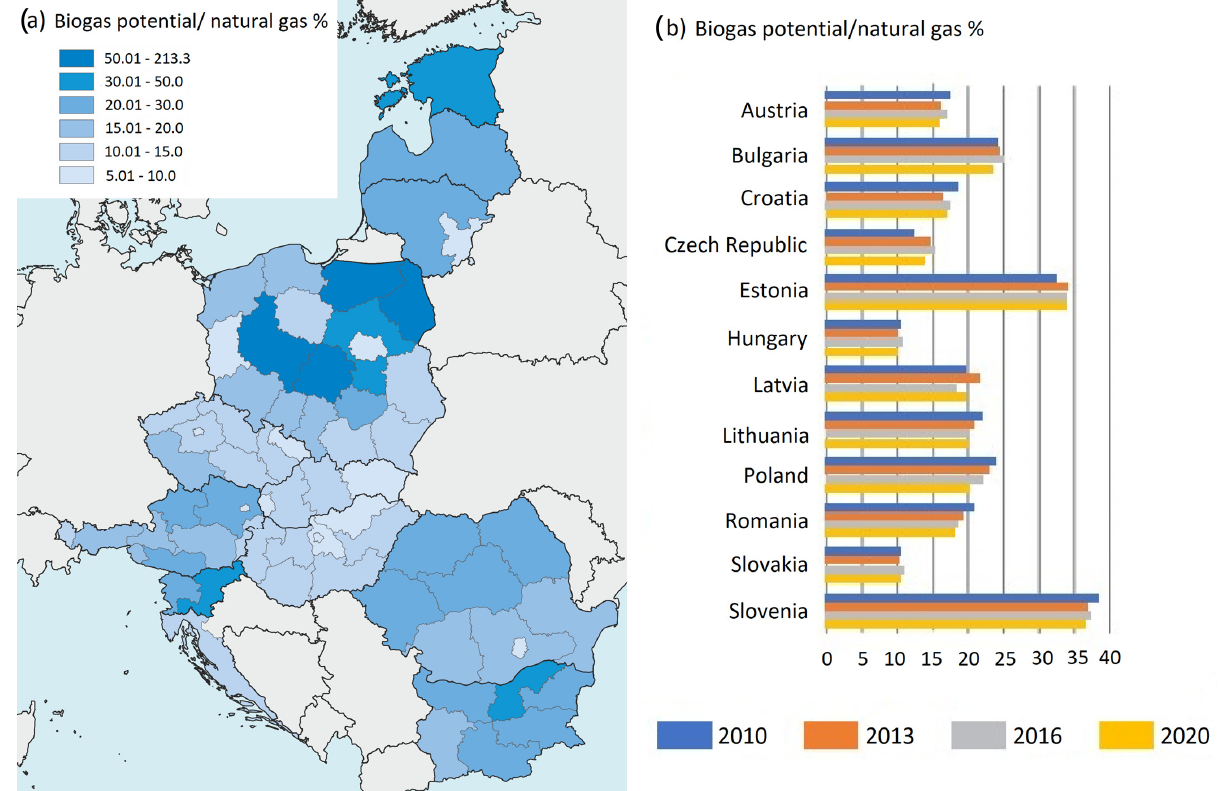
Figure 3. Biogas potential in relation to the consumption of natural gas in 2021 ( a ) and its variation in selected years ( b ).